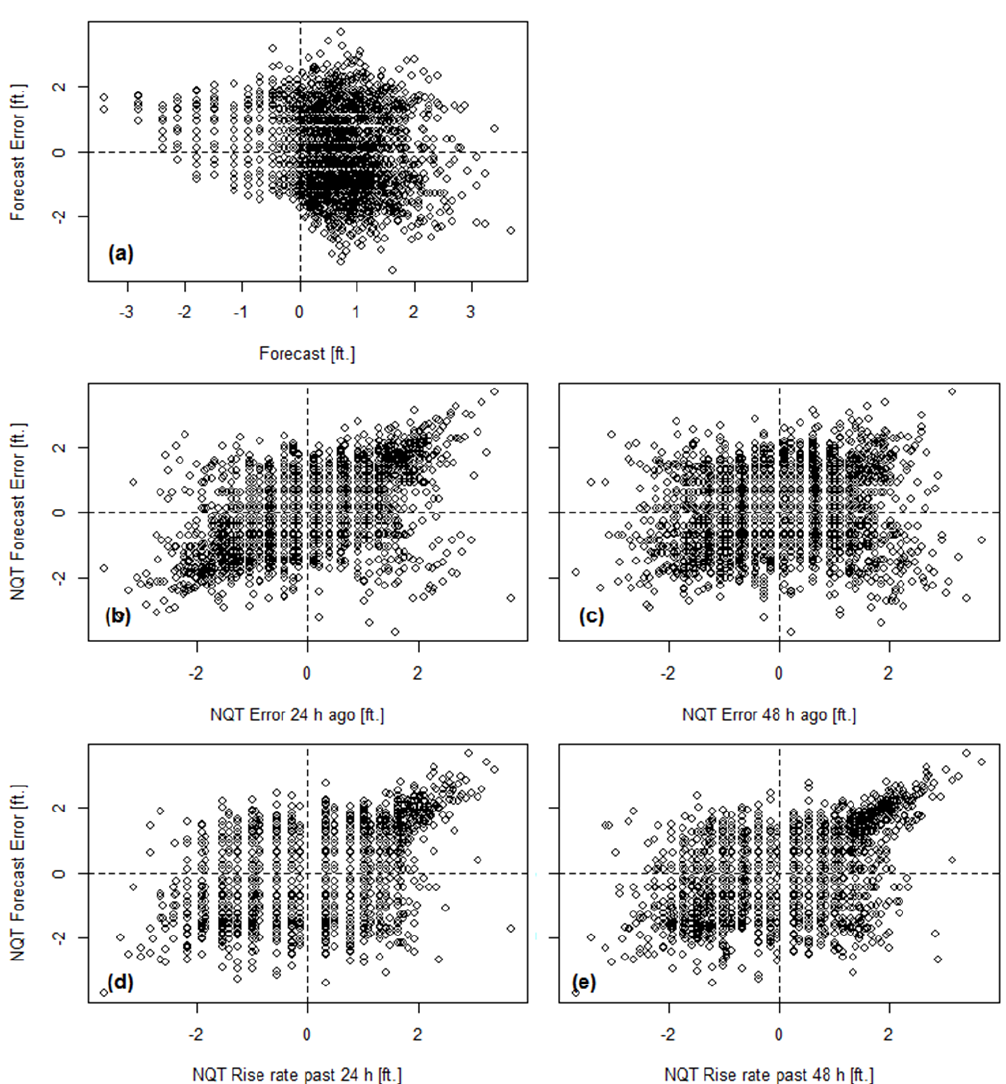
Figure 12. Independent variables after transforming into the Gaussian domain plotted against the forecast error for Hardin, IL, with 3 days of lead time. First row: forecast; second row: past forecast errors; third row: rates of